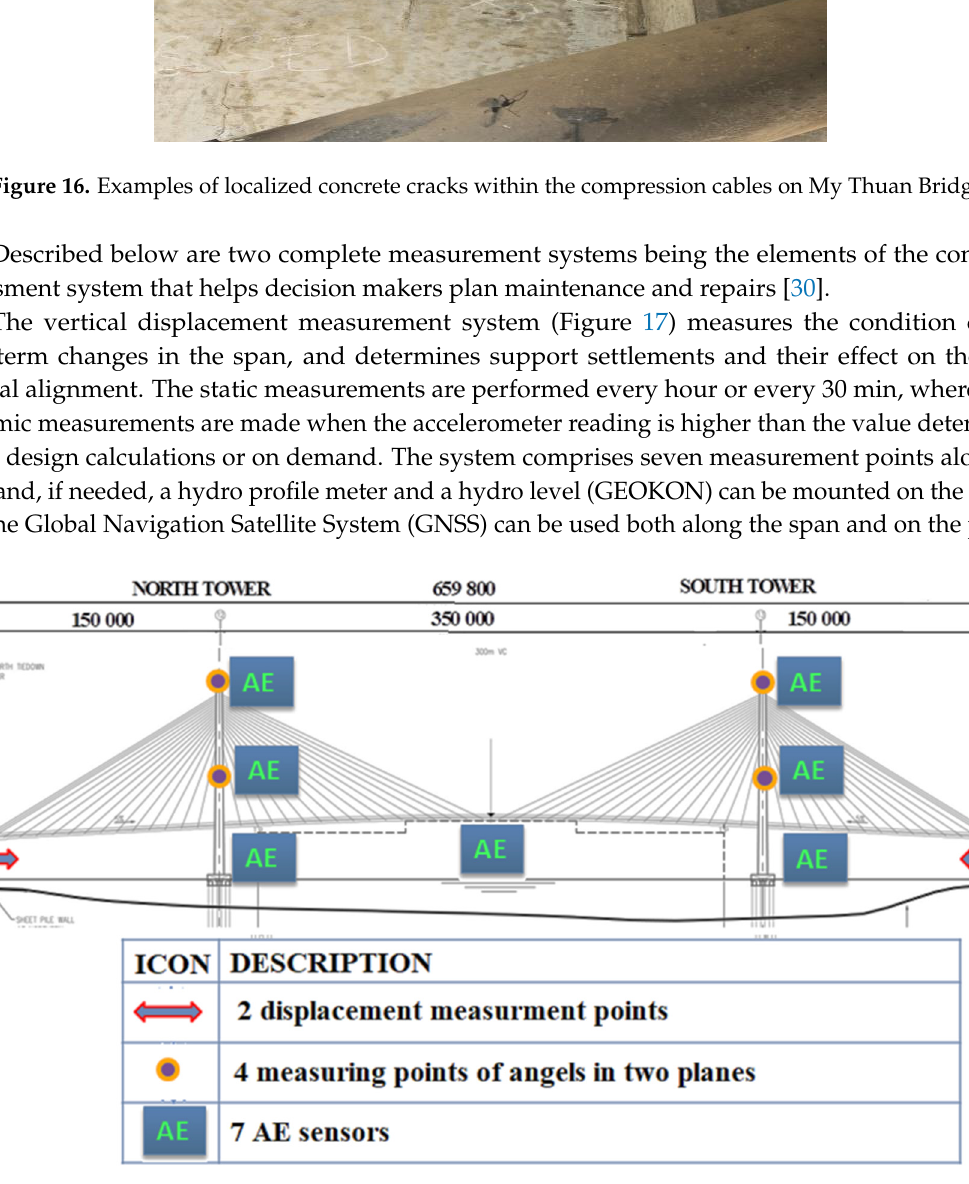
Figure 17. Arrangement of measurement points in the vertical displacements system.